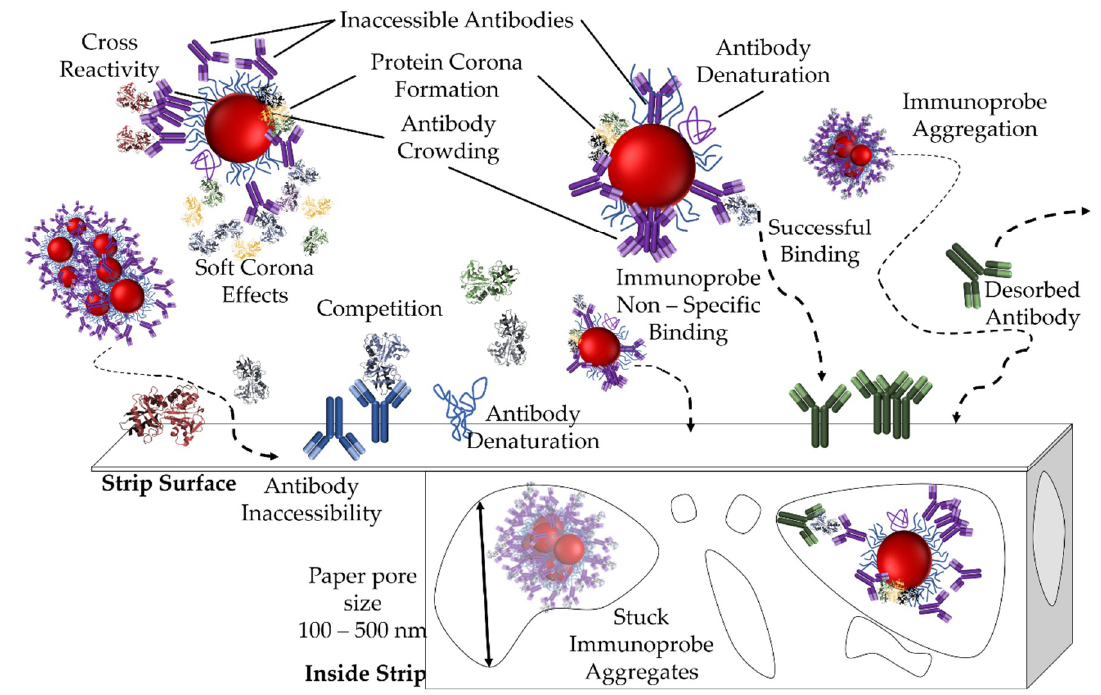
Figure 9. Challenges associated with paper-based immunoassays. Adapted from Reference [36]. Arrows represent particle trajectory.